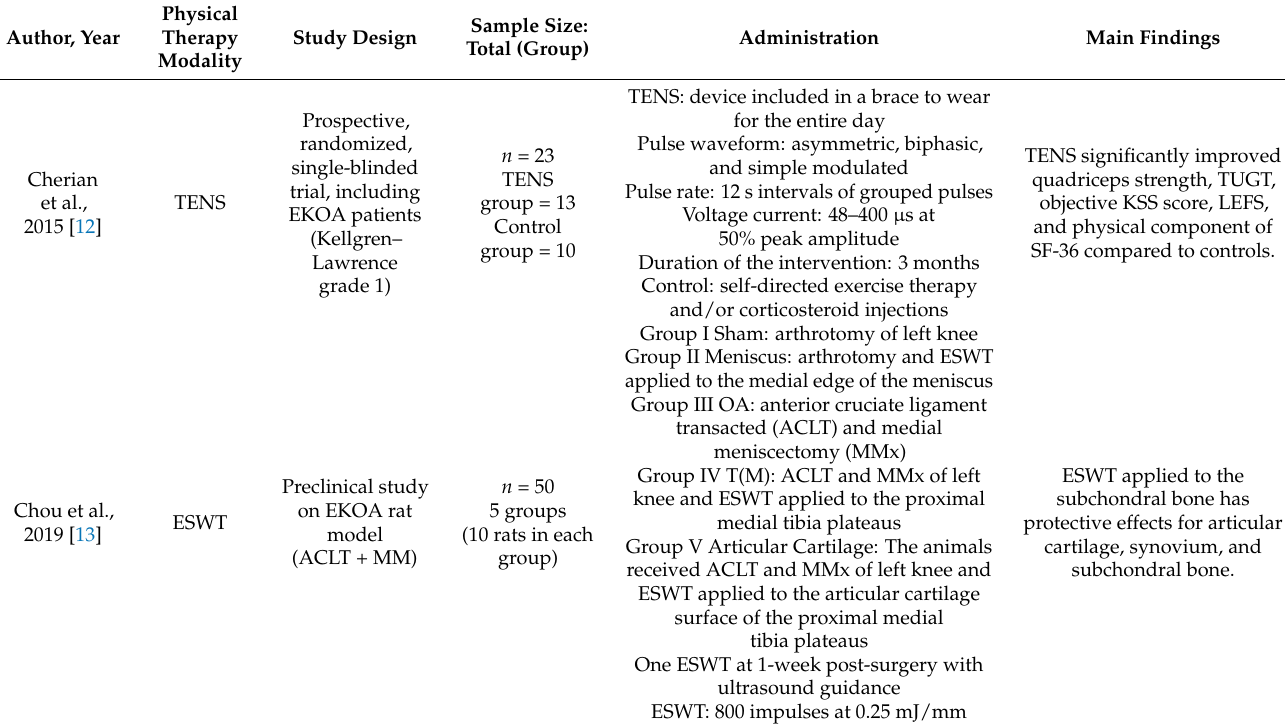
Figure 1. PRISMA-ScR flow diagram of the study selection process. Table 3. Characteristics and findings of the included studies evaluating the effects, efficacy, and effectiveness of physical agent modalities in early